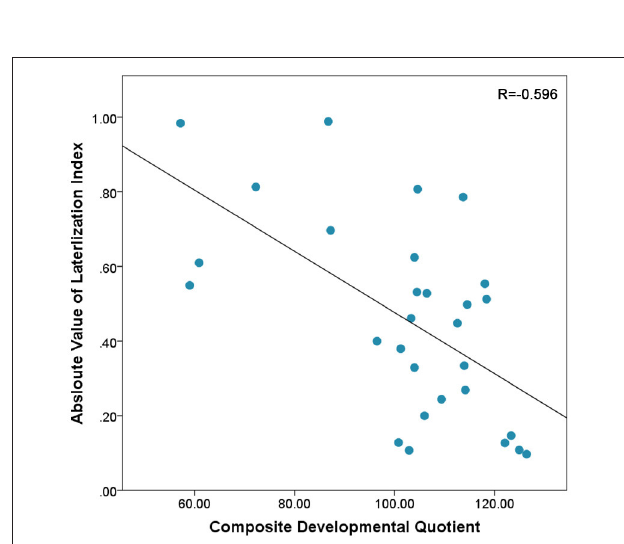
FIGURE 4 | Correlation between Absloute values of Laterlization Index and Composite-DQ indicating higher differences between left and right PFC activation in subjects with lower